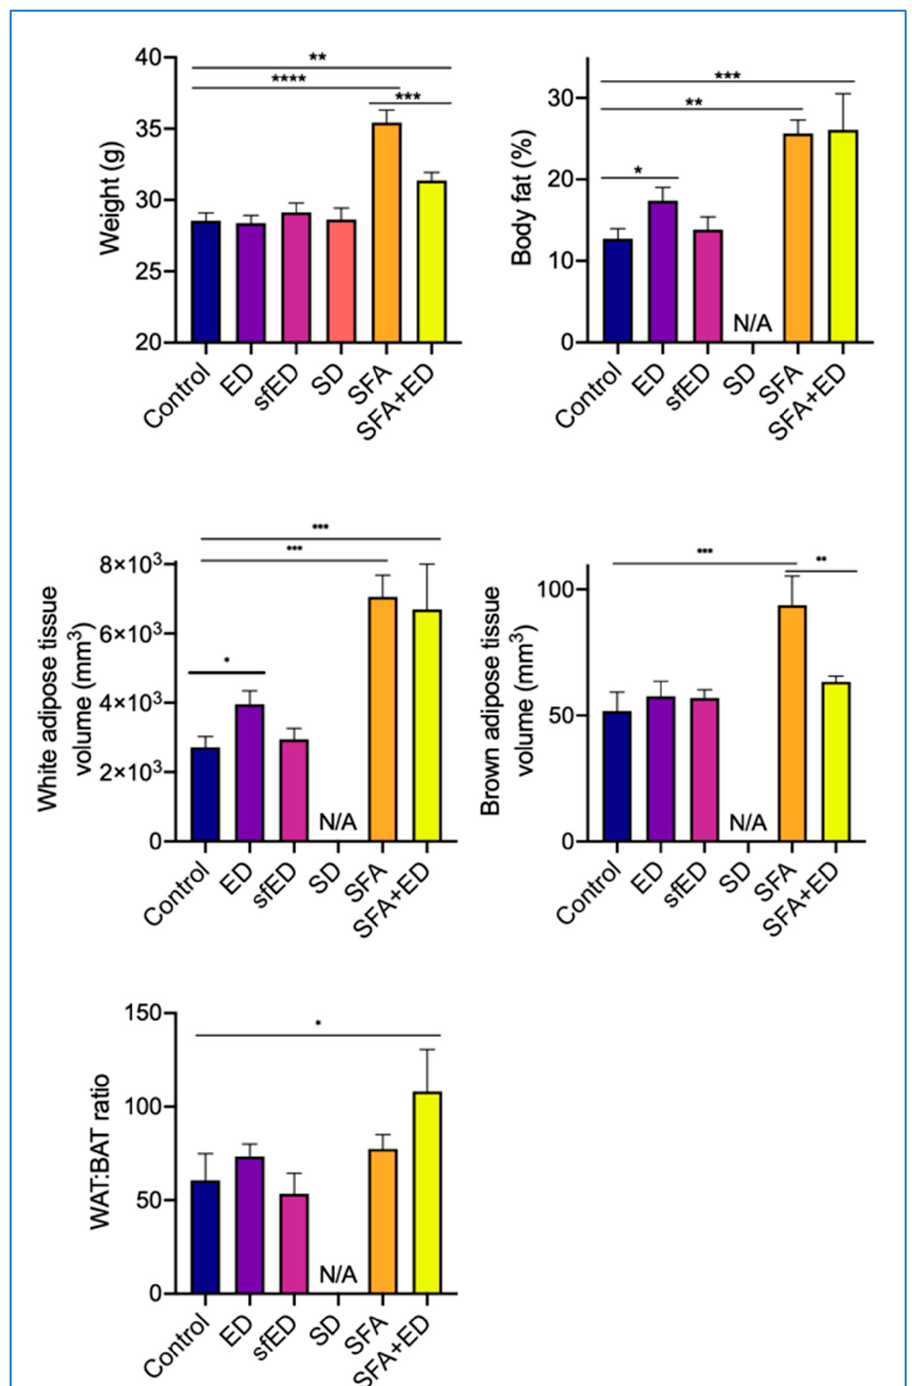
Figure 2. Weight gain and body fat. The mice received no liquid intervention (control), Mother (ED), sugar-free Mother (sfED), Coca-Cola (SD), saturated fat enriched diet (SFA) or SFA with ED (SFA + ED) for 13 weeks. The mice were weighed weekly. The body fat percentage, white adipose tissue (WAT) volume, brown adipose tissue (BAT) volume and WAT:BAT ratio were recorded from five randomly selected mice per group (except for SD group) by using Skyscan in vivo x-ray microtomography. Statistical significance was tested using a one-way ANOVA with Fisher’s LSD post hoc test (* p < 0.05, ** p <0.005, *** p < 0.0005, **** p < 0.0001).